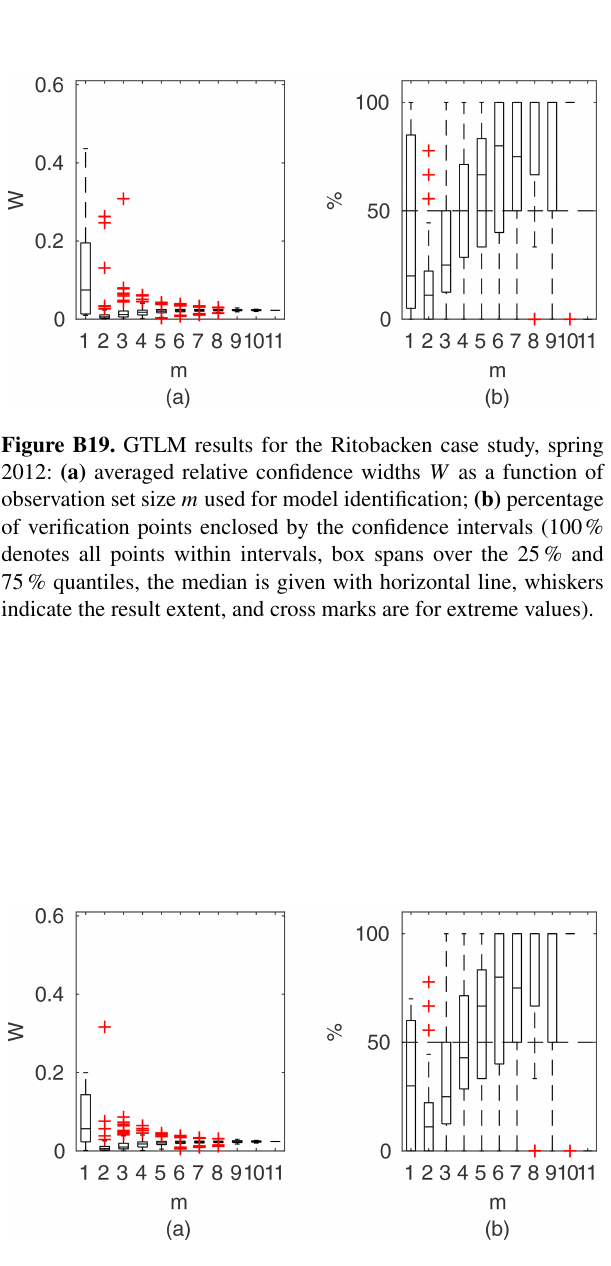
Figure B20. STLM results for the Ritobacken case study, spring 2012: (a) averaged relative confidence widths W as a function of observation set size m used for model identification; (b) percentage of verification points enclosed by the confidence intervals (100% denotes all points within intervals, box spans over the 25% and 75% quantiles, the median is given with horizontal line, whiskers indicate the result extent, and cross marks are for extreme